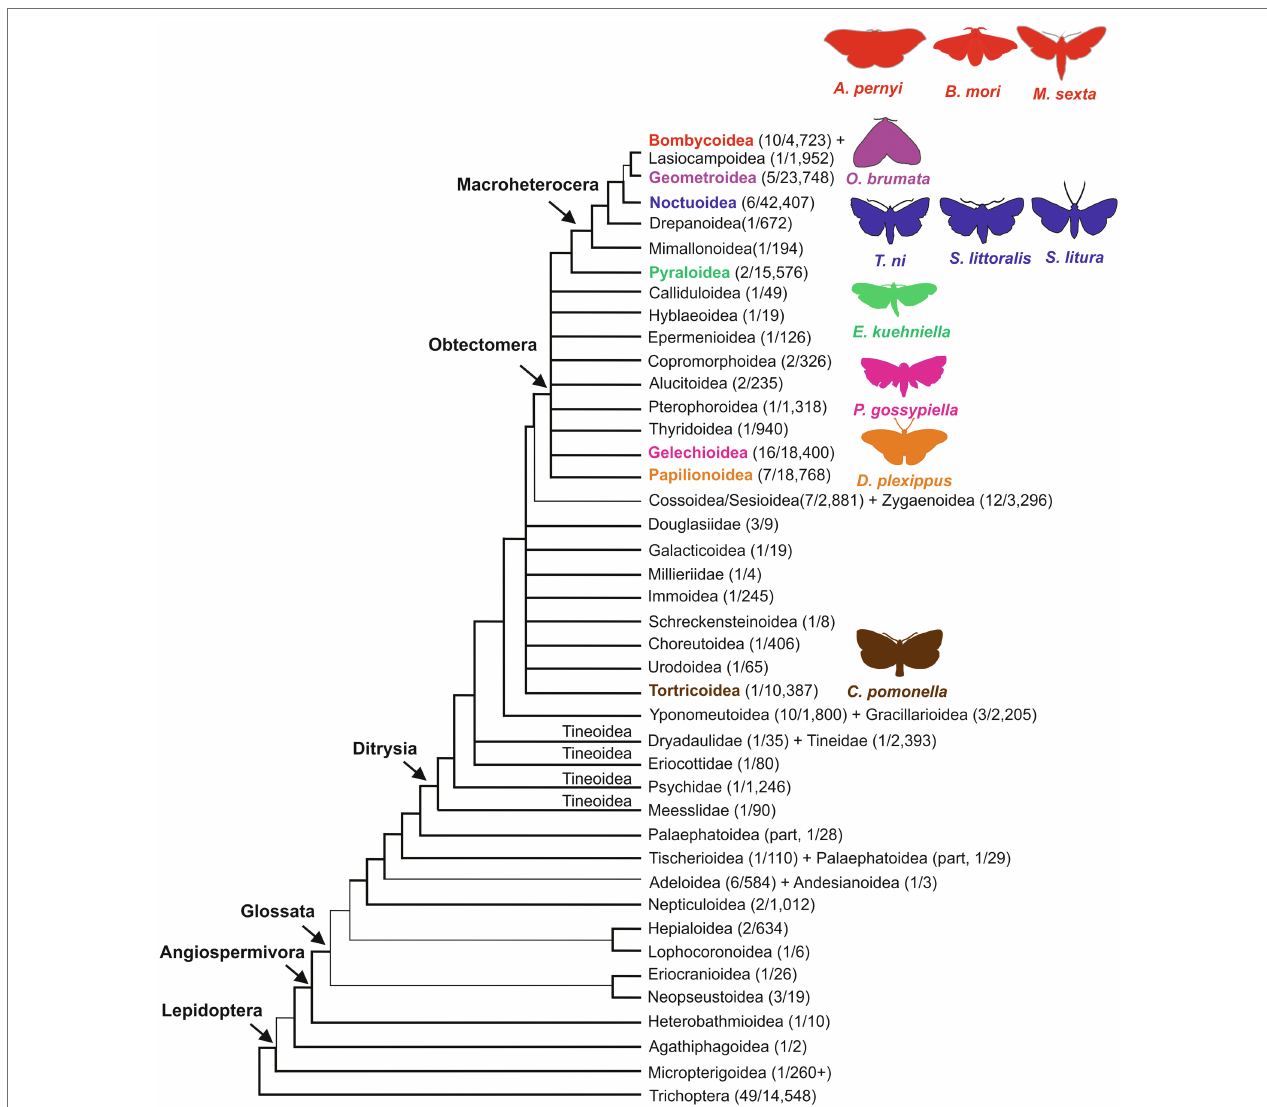
FIGURE 1 | Phylogeny of Lepidoptera superfamilies, including Trichoptera, sister group to Lepidoptera (Mitter et al., 2017). Superfamilies, including species with at least one circadian phenotype described in this review, are reported with different colors: brown: Tortricoidea; orange: Papilionoidea; magenta: Gelechioidea; green: Pyraloidea; blue: Noctuoidea; purple: Geometroidea; and red: Bombycoidea. Representative species of each superfamily are shown using the same color code. As in Mitter et al. (2017), thicker lines indicate more strongly recognized groupings; numbers within parenthesis indicate the number of families/species. On the left, the following higher-level classification groups are shown: Angiospermivora, angiosperm feeding; Glossata, acquisition of the proboscis in adults; Ditrysia, a clade containing 98% of lepidopteran species; Obtectomera, a clade comprising butterflies and macro-moths; Macroheterocera, a clade of moths including superfamilies previously placed in the Macrolepidoptera group, which is currently not considered a monophyletic group (Mimallonoidea, Drepanoidea, Noctuoidea, Geometroidea, Lasiocampoidea, and Bombycoidea; Mitter et al., 2017). Modified from Mitter et al.